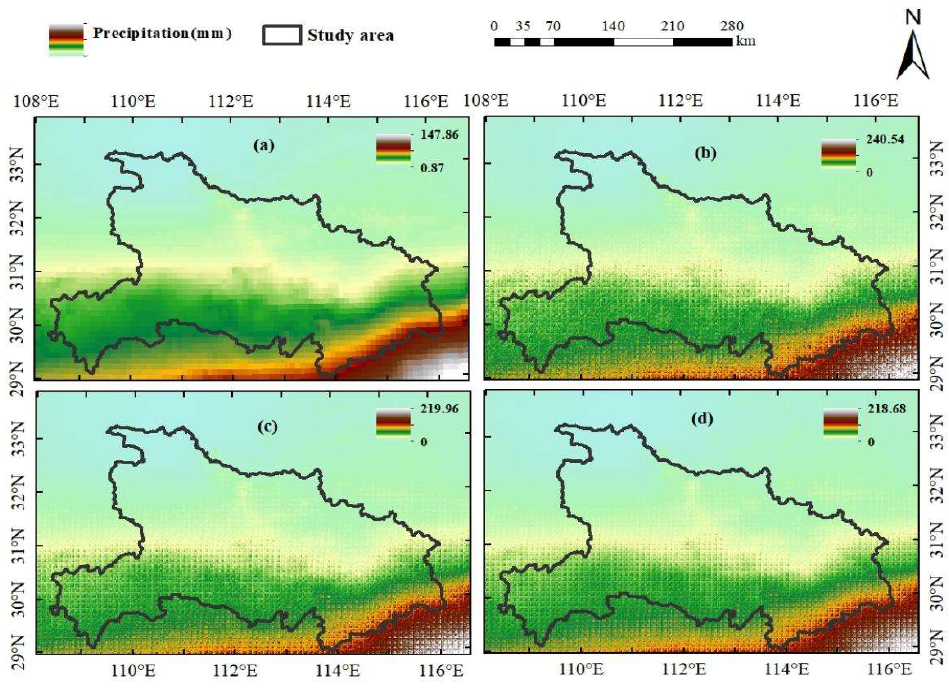
Figure 9. Initial 10 km precipitation grid ( a ) and the downscaled results of running the cascade process for 10 times ( b ), 20 times ( c ), and 50 times ( d ) in December 2015.